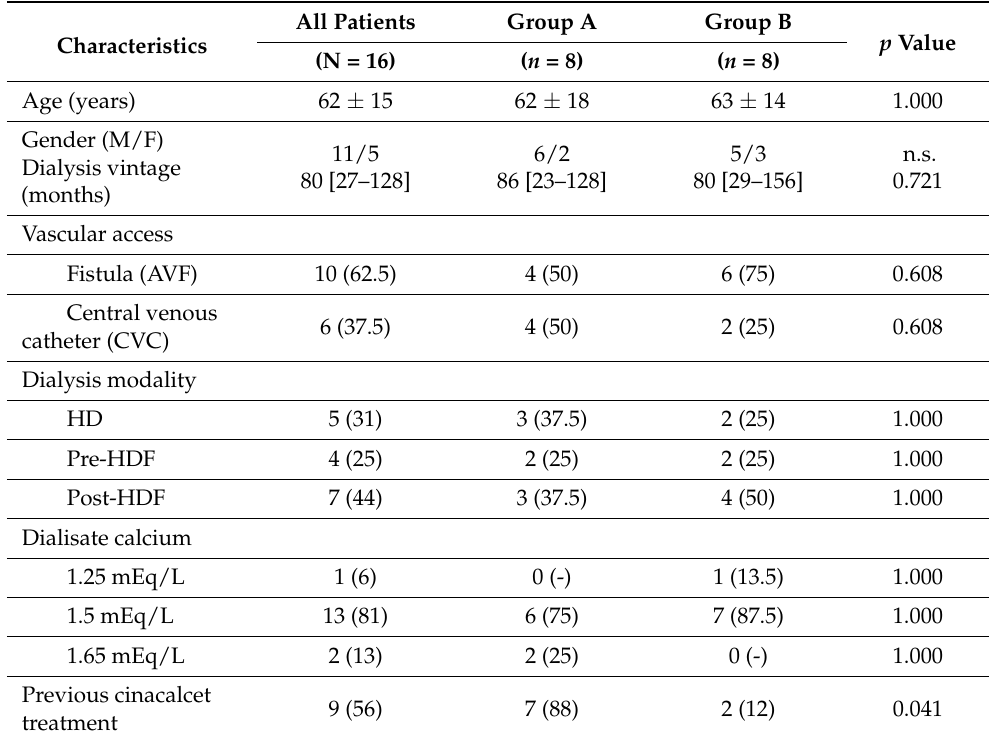
Table 1. Characteristics of the study population. Abbreviations: HD, hemodialysis, bicarbonate dialy- sis; HDF pre, pre-dilution hemodiafiltration; Post HDF, post-dilution hemodiafiltration. Categorical variables are expressed in number (percent), continuous variables in mean ± standard deviation or, in case of non-Gaussian distribution, in median [interquartile range].